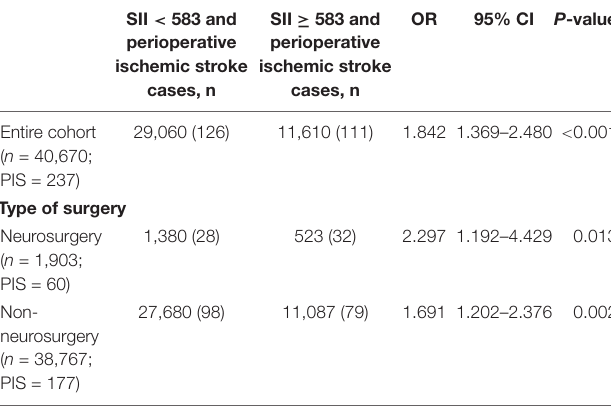
TABLE 3 | Sensitivity analysis of the association between SII and perioperative ischemic stroke (adjustment through multivariate logistic regression). SII < 583 and perioperative ischemic stroke cases, n